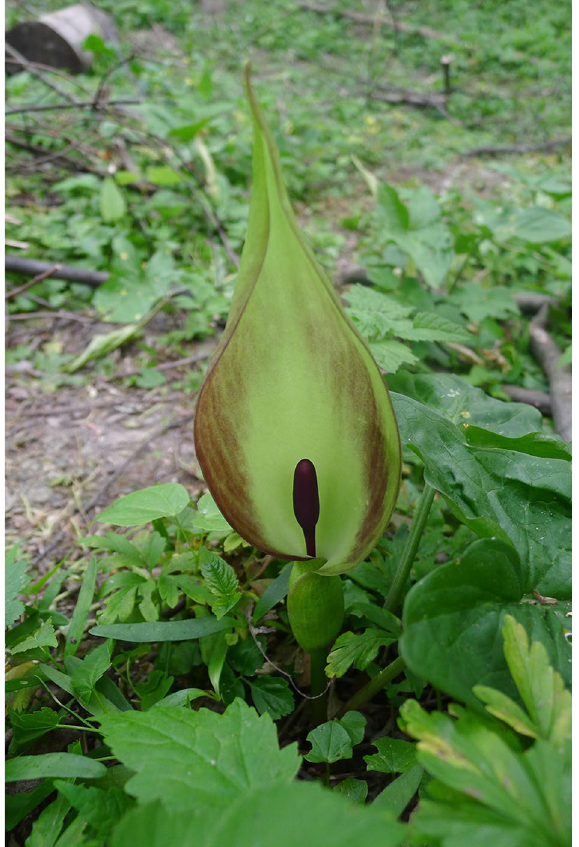
Figure 1. A flowering individual of Arum maculatum in its natural habitat. (Photo E. Gfrerer; Salzburg,